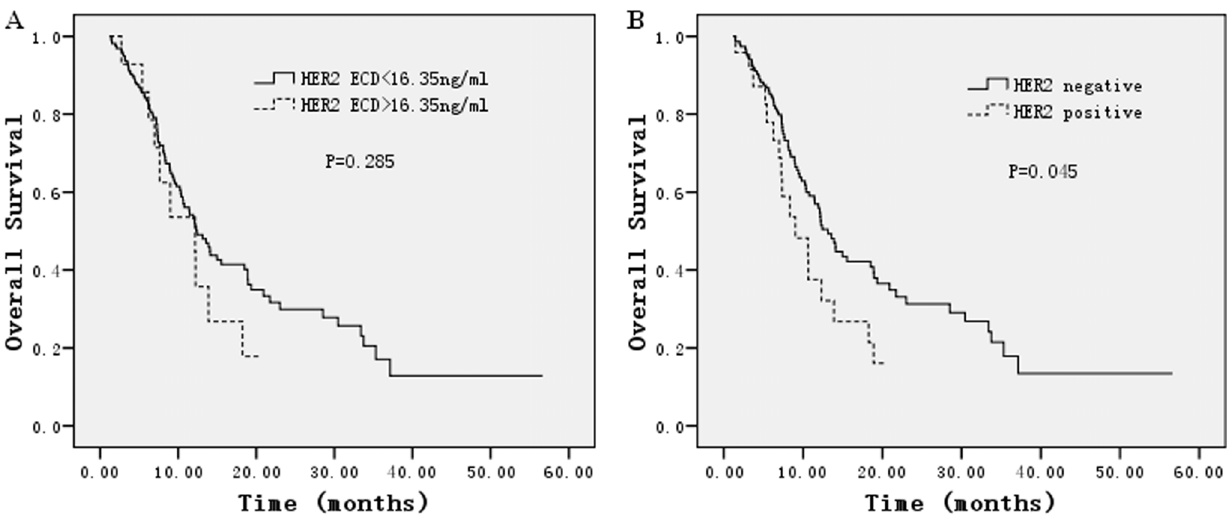
Figure 4. Kaplan–Meier estimates for overall survival according to serum HER 2 ECD levels and tissue HER 2 status. Serum HER 2 ECD levels showed no association with overall survival. Whereas positive tissue HER 2 status was significantly associated with worse overall